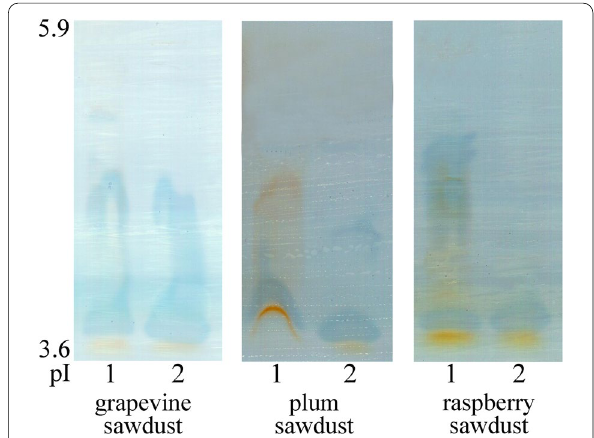
Fig. 3 Activity of endo-glucanases, exo-glucanases, xylanases and β-glucosidases of Pleurotus spp. depending on the type of pomiculture residues. The values with the same superscript letter (for each enzyme) are not significantly different ( p <